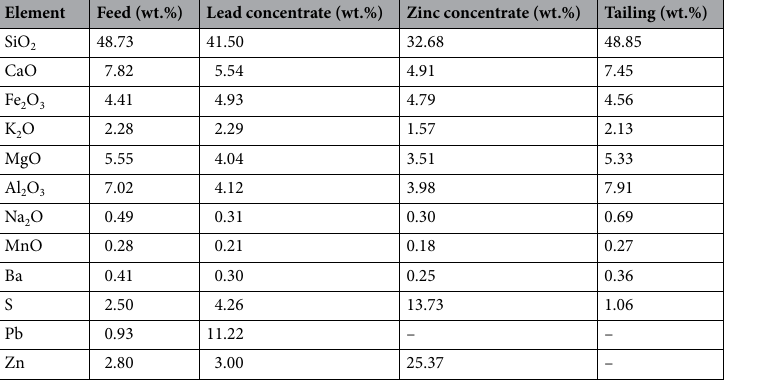
Table 1. A correct version of the original Table